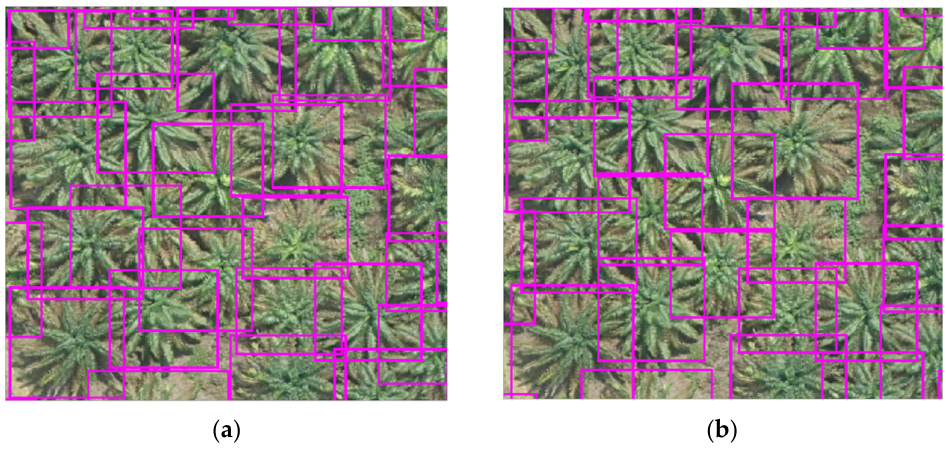
Figure 13. Comparison of the bounding box location to the detected object of the YOLOv3 detection results: ( a ) Poor accuracy on the network input size 416 × 416; ( b ) Good accuracy on the network input size 1024 × 1024.